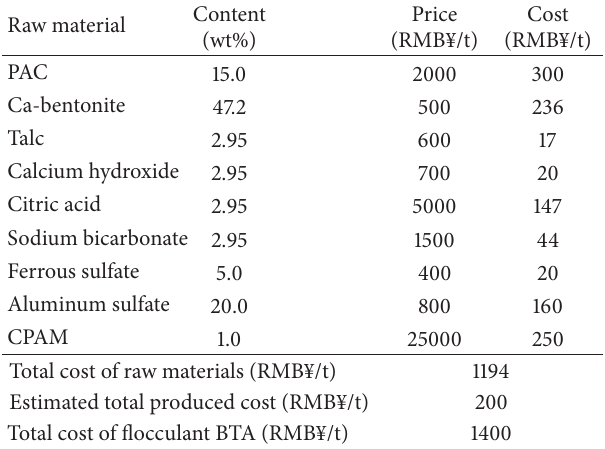
Table 8: The costing evaluation for flocculant BTA based on the price of raw materials purchased from Beijing chemical market in 2013.